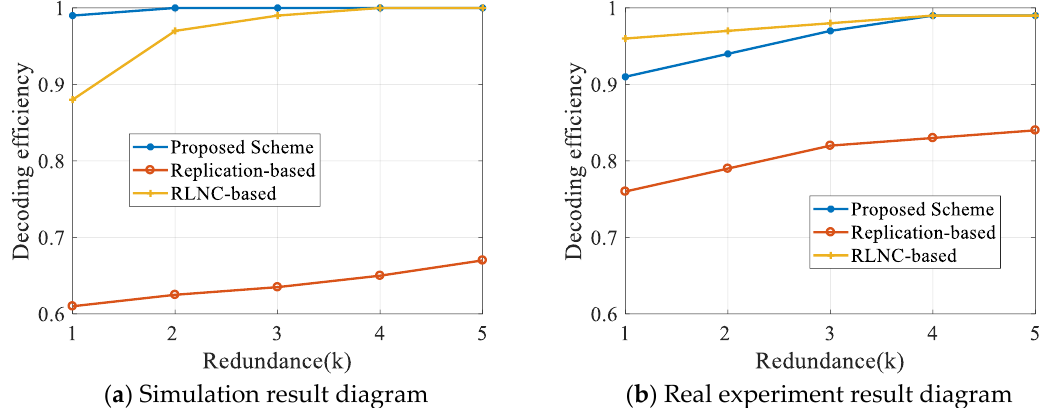
Figure 7. Influence of redundancy on SDR.